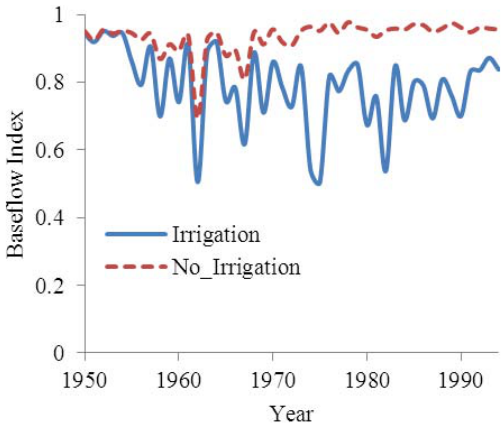
Fig. 6. Baseflow index for non-irrigation and irrigation